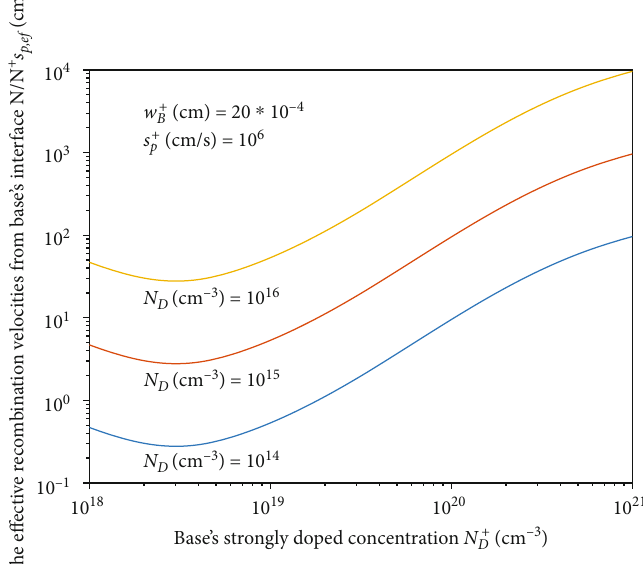
’ s strongly doped concentration N p , ef dependent on base